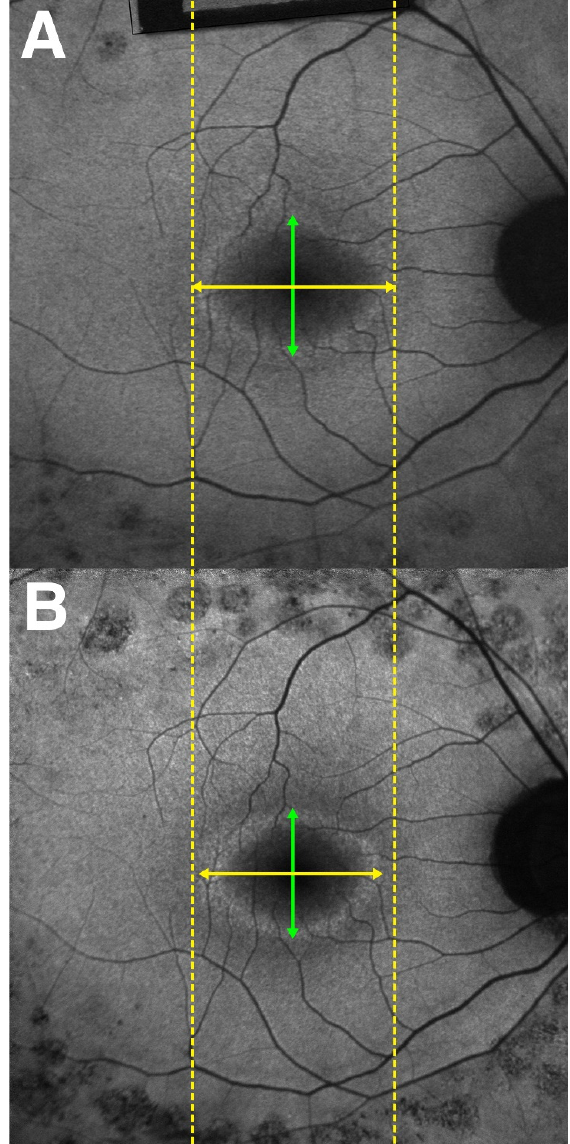
Figure 6. Progression of hyperautofluorescent ring diameters seen in short-wavelength autofluorescence (SW-AF) imaging of a patient with retinitis pigmentosa (RP). ( A ) A SW-AF scan of a hyperautofluorescent ring in RP at the baseline visit. Dashed yellow lines are tangential to the horizontal-most edges of the hyperautofluorescent ring. Green lines span the vertical diameter of the ring, while yellow lines span the horizontal diameter. The horizontal diameter of the ring is noticeably larger at the baseline visit than at the follow-up ( B ).